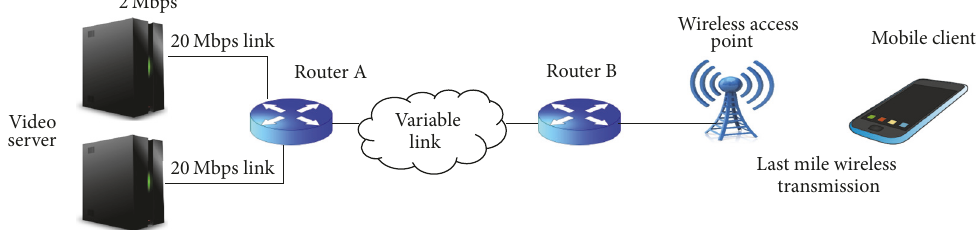
Figure 5: Simulation